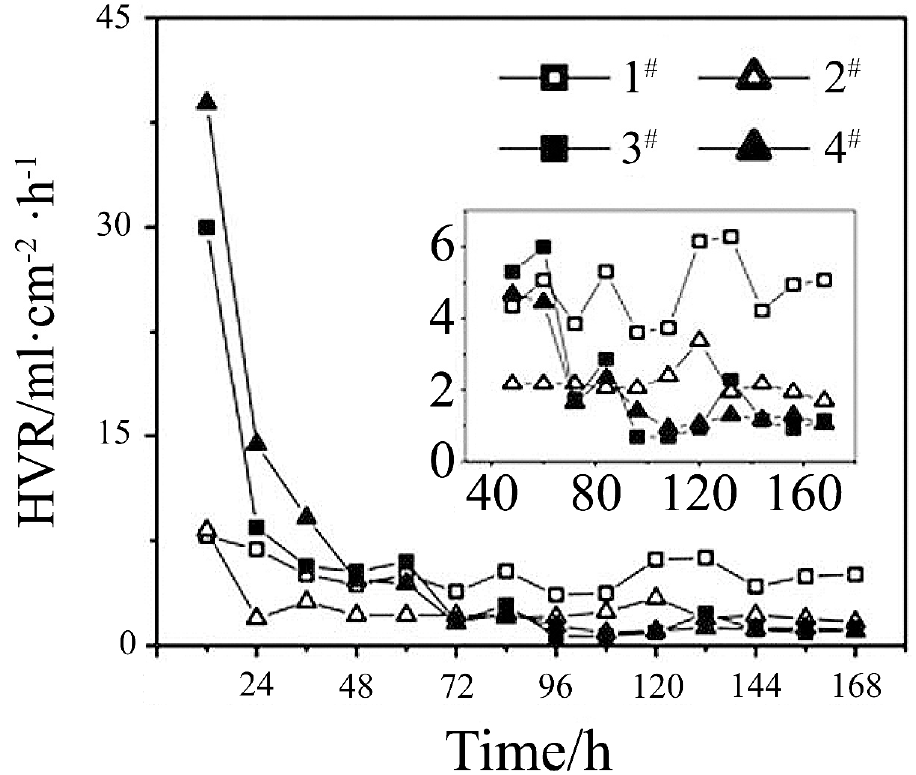
Figure 3. HE rates for an AZ91 alloy as a function of immersion time in the four solutions: 1 # Cl − ; 2 # Cl − and HPO 42 − ; 3 # Cl − , HPO 42 − and CO 32 − ; 4 # Cl − , CO 32 − , SO 42 − , and HPO 42 − [134].